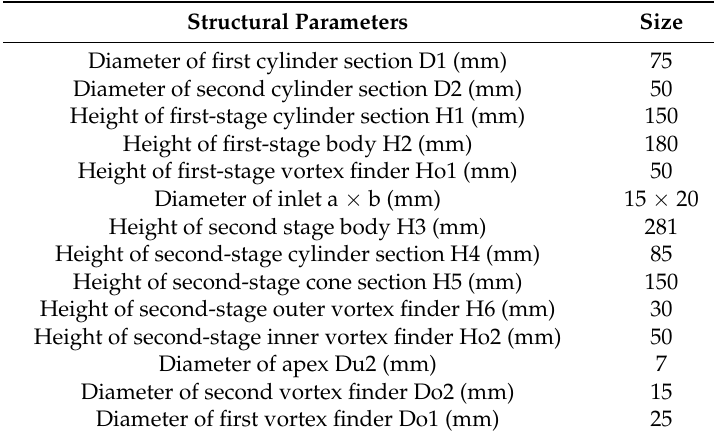
Table 1. Structural parameters of